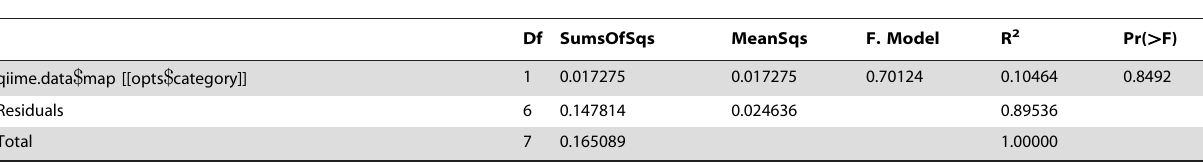
Table 5. ADONIS differences between ZD and